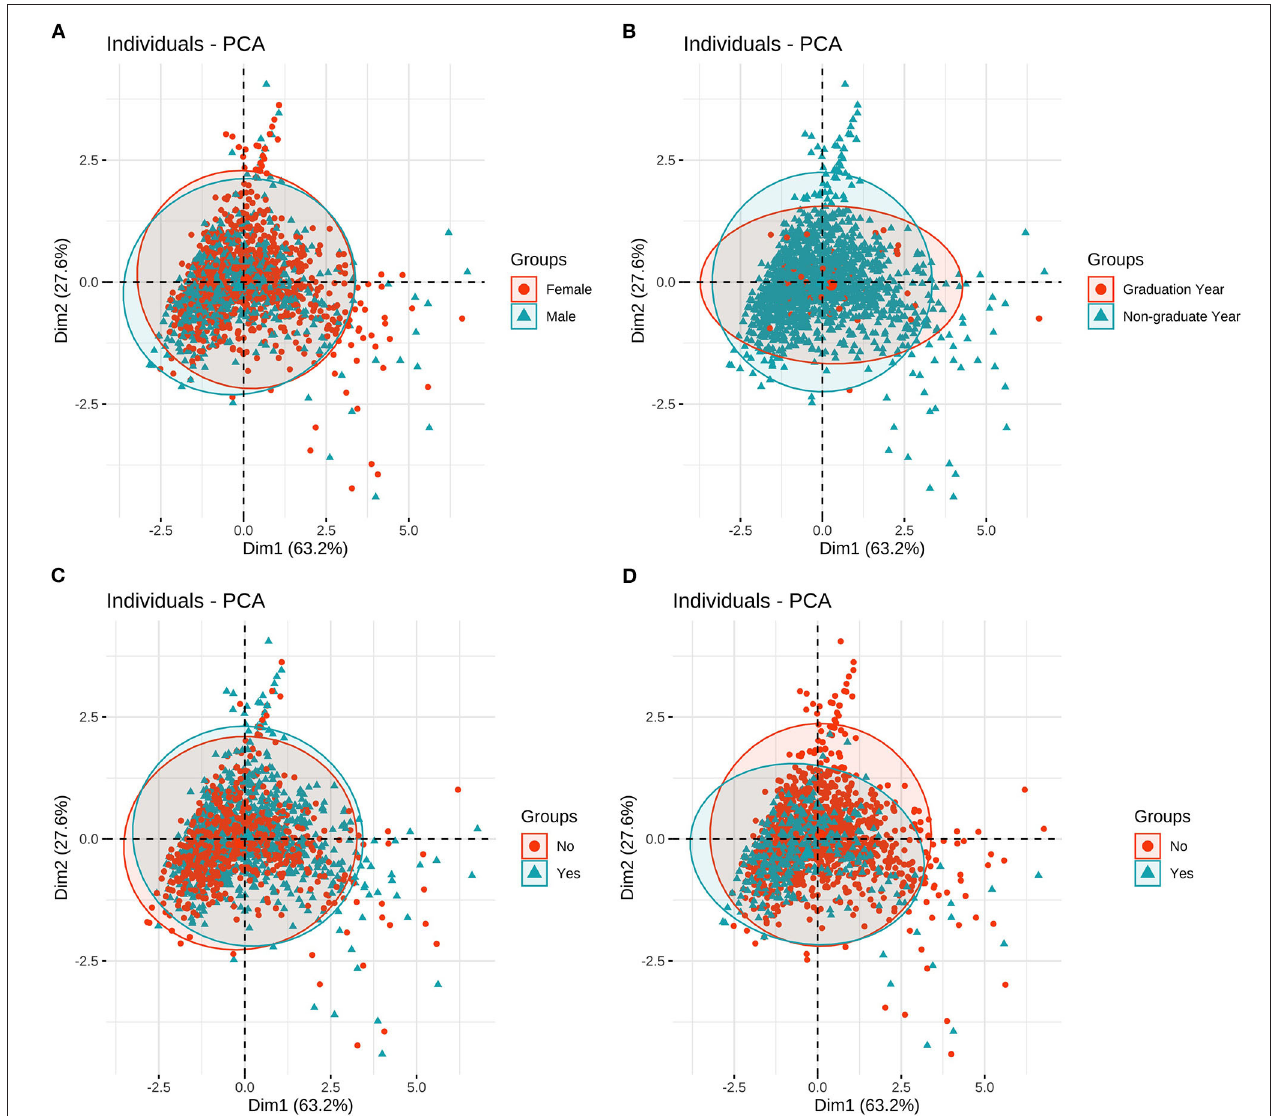
FIGURE 1 | Principal component analysis of different groups. (A) Principal component analysis of different genders; (B) Principal component analysis of different grades; (C) Principal component analysis of different majors; (D) Principal component analysis of resuming-school or